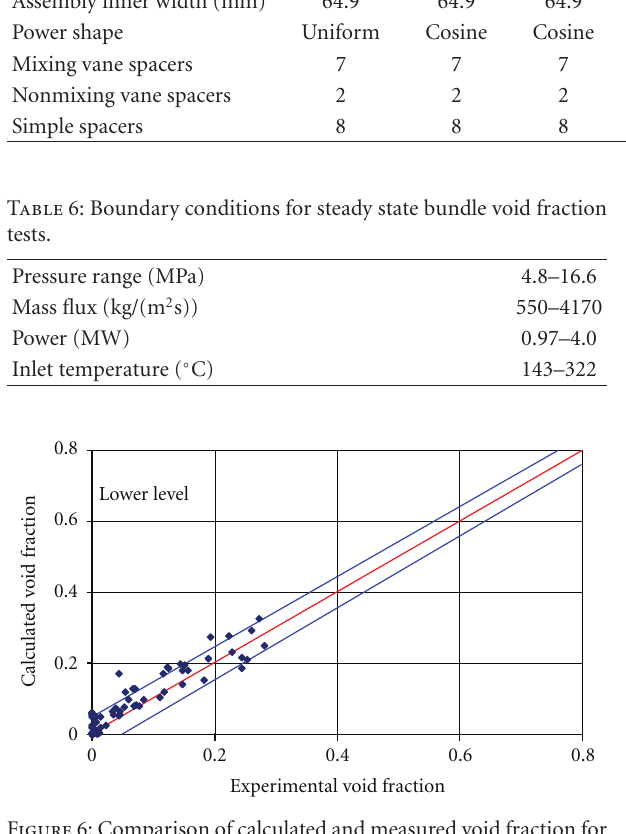
Figure 6: Comparison of calculated and measured void fraction for case B5 at the lower axial level.